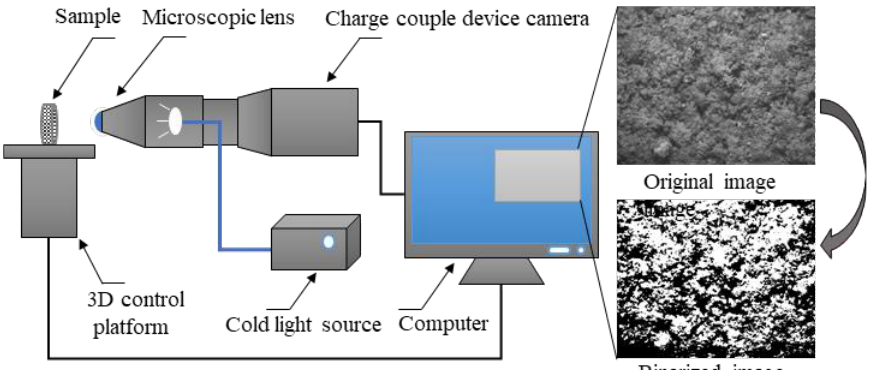
Figure 3. Soil microstructure test method.